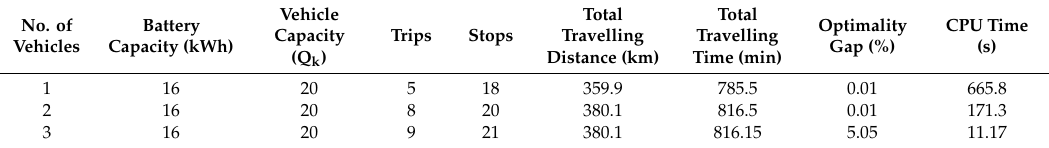
Table 12. The optimal solutions under di ff erent numbers of vehicles used for the rebalancing operation. No. of Vehicles